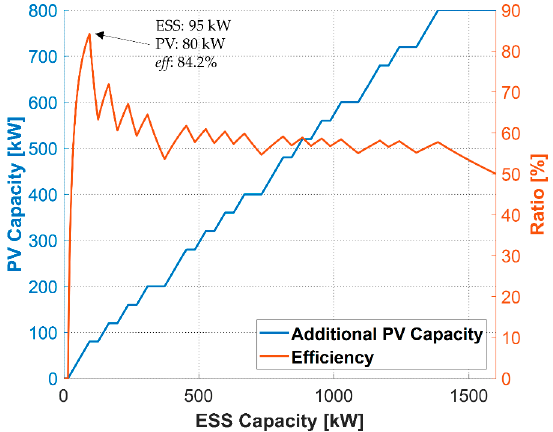
Figure 10. Additional capacity and ratio of the PV when the ESS is installed.